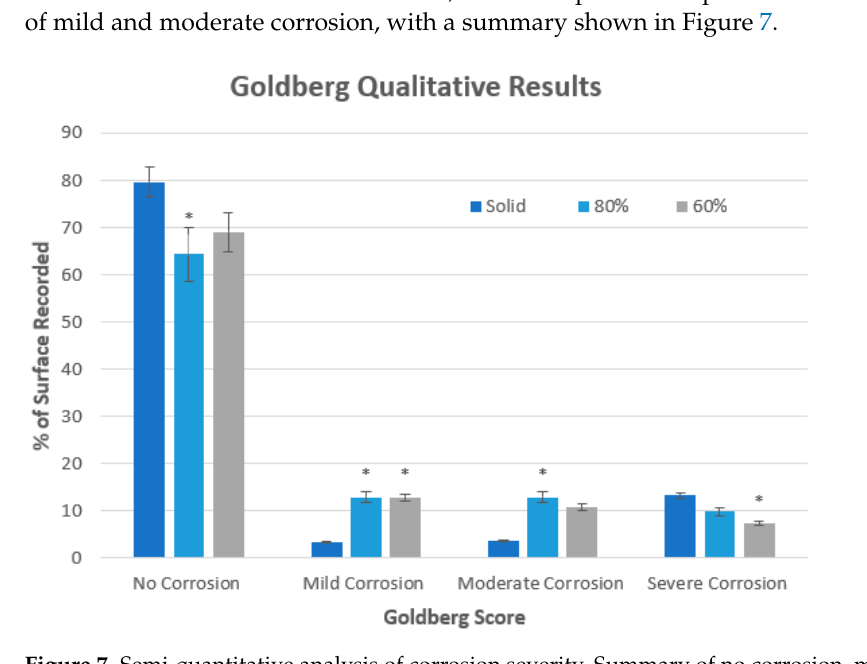
Figure 7. Semi-quantitative analysis of corrosion severity. Summary of no corrosion, mild, moderate, and severe corrosion on solid, 80% gyroid and 60% gyroid samples. * Indicates statistical significance to solid test group ( p < 0.5). No significant differences were detected between the two porous groups (60% and 80% gyroids) (One-way ANOVA,